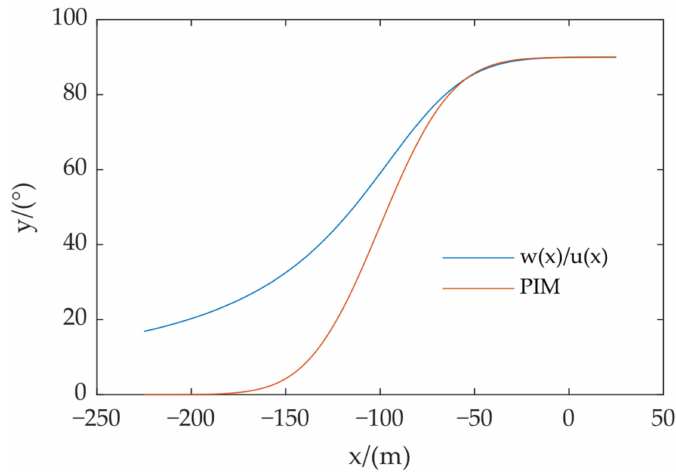
Figure 7. Comparisons of the depression angles of the strike main